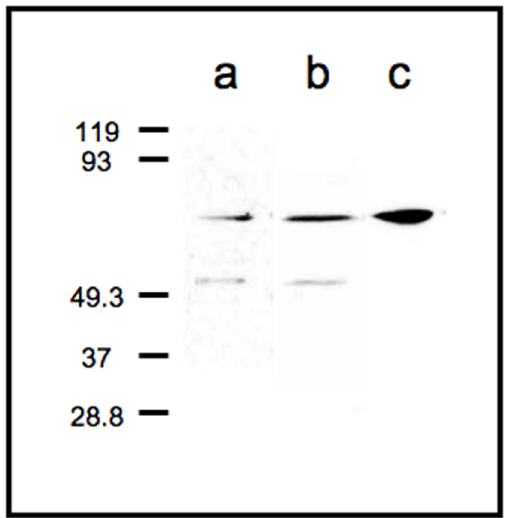
Figure 1. Western blot of hippocampal protein extracts. Stained with anti-saposin B ( a ) and D ( b ) antibodies. Two bands of approximately 50 kDa and 69 kDa (PS) were detected. ( c ) Stained with the specific anti-PS antibody. Only one band of PS was detected.